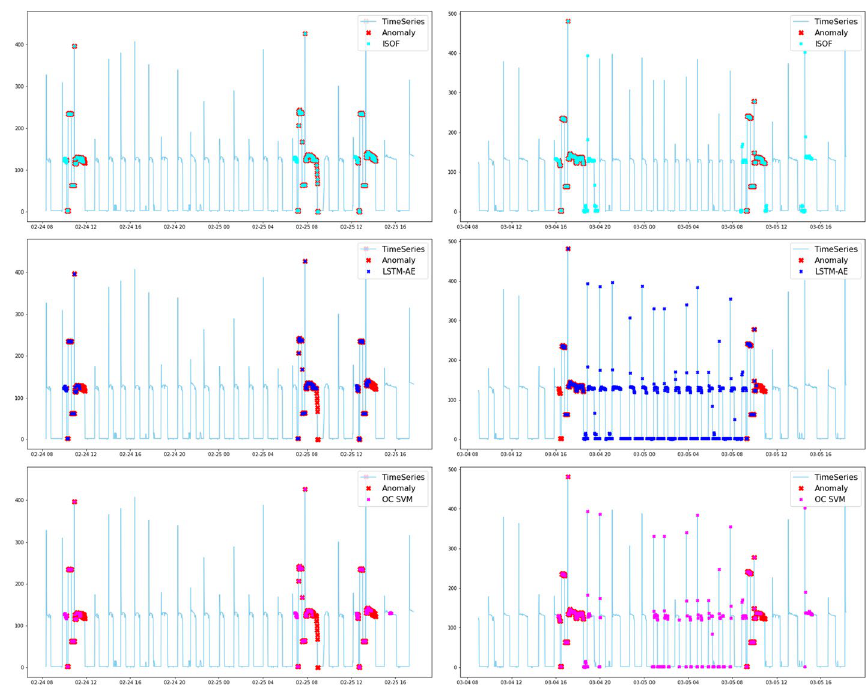
Fig. 11 Qualitative analysis of the predictions of three methods on Fridge1: ISOF, LSTM-AE, OC SVM. ISOF (top) is more robust to the variations of the duration of the cycles, while the others show a weakness in the identification of the anomalous points, in fact, LSTM-AE (middle) and OC SVM (bottom) label numerous normal points as